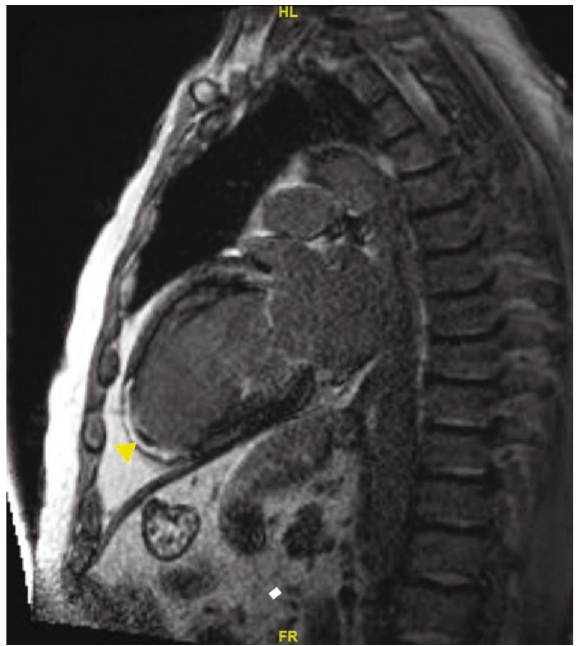
Figure 1: Delayed enhanced cardiac magnetic resonance image. Delayed enhanced cardiac MR (CMR) demonstrating an apical laminar thrombus (blocked